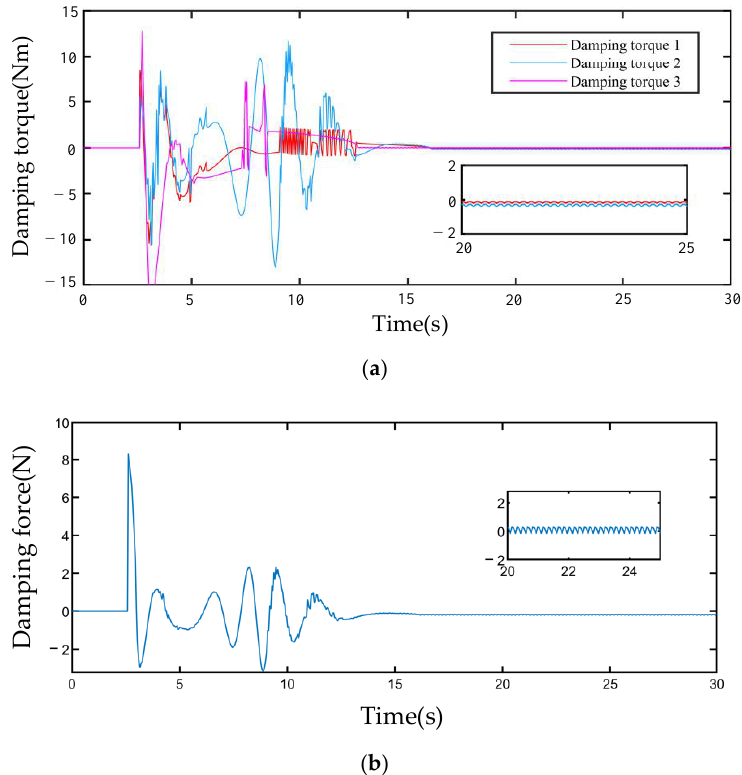
Figure 10. The damping force and torque outputs by the dampers of FDCDM.